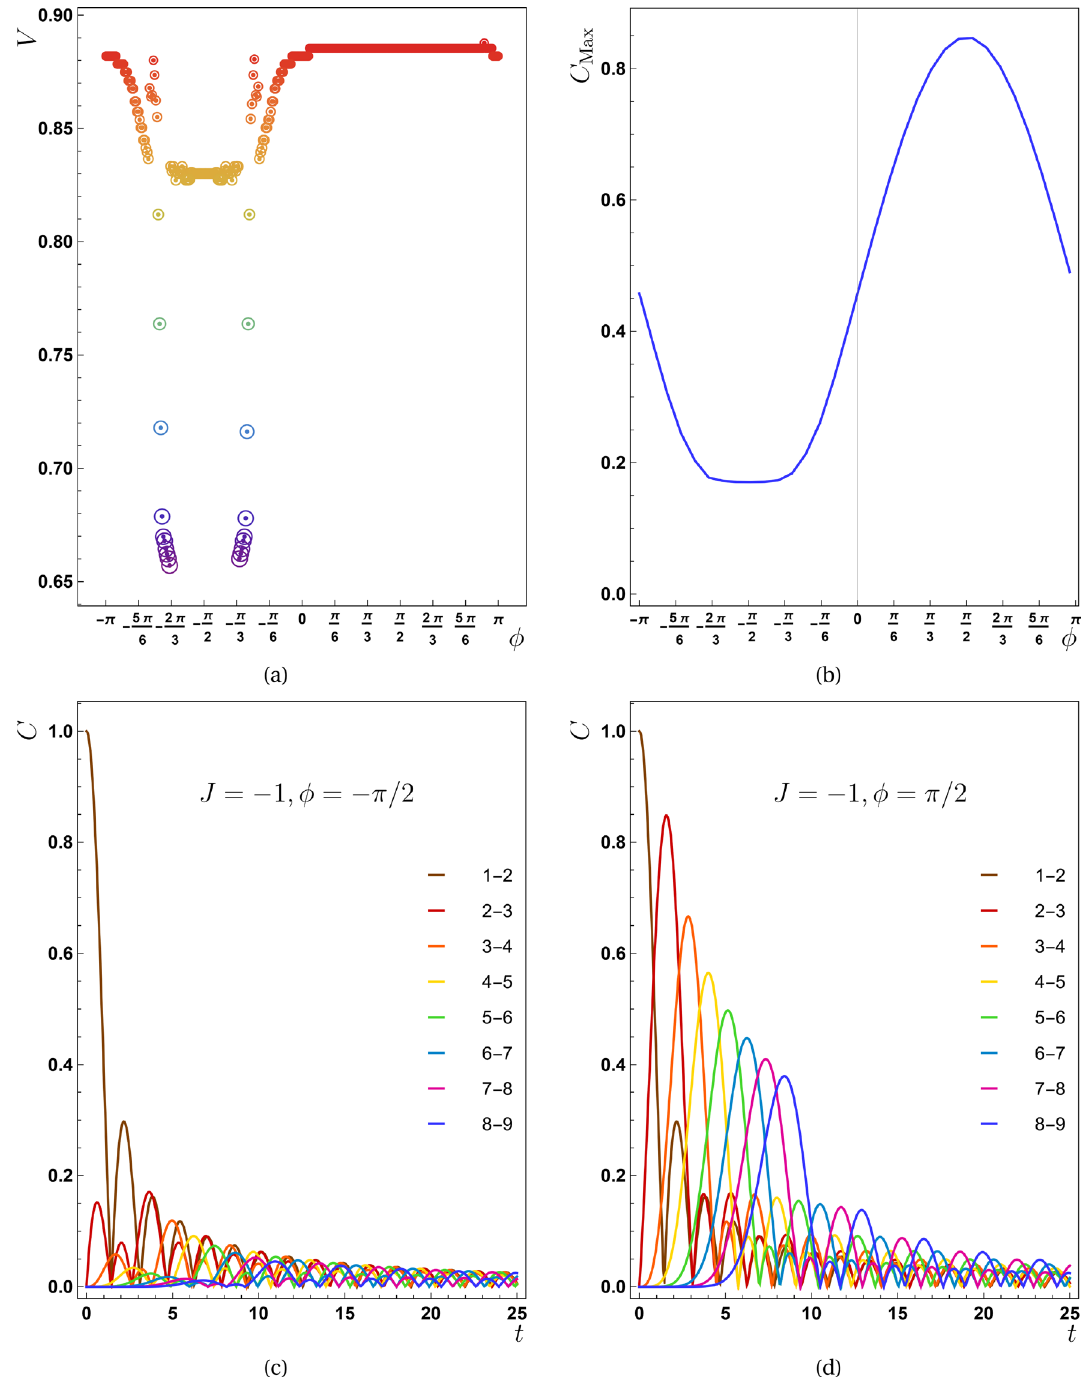
1.0 . The drops that Figure 2. ( a ) The propagation speed is plotted against the phase factor ( φ ) with J = − π/ 2 . ( b ) The maximum value of the concurrence function for experienced by this quantity is around φ = the pair (2, 3) versus φ . By comparing panels ( a ) and ( b ), we can see that the lowest entanglement value is π/ 2 and responsible for a phase interval during which the velocity reaches its lowest value. Panels ( c ) for φ = − π/ 2 show the effect of φ on the maximum entanglement. The last two panels are in good agreement ( d ) for φ = with the panel ( b